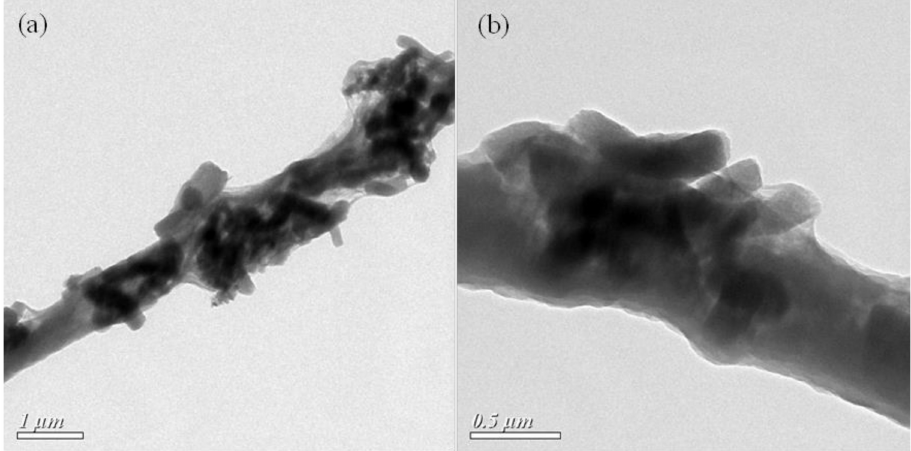
Figure 4. TEM images of 60% M-P: ( a ) fiber and ( b )